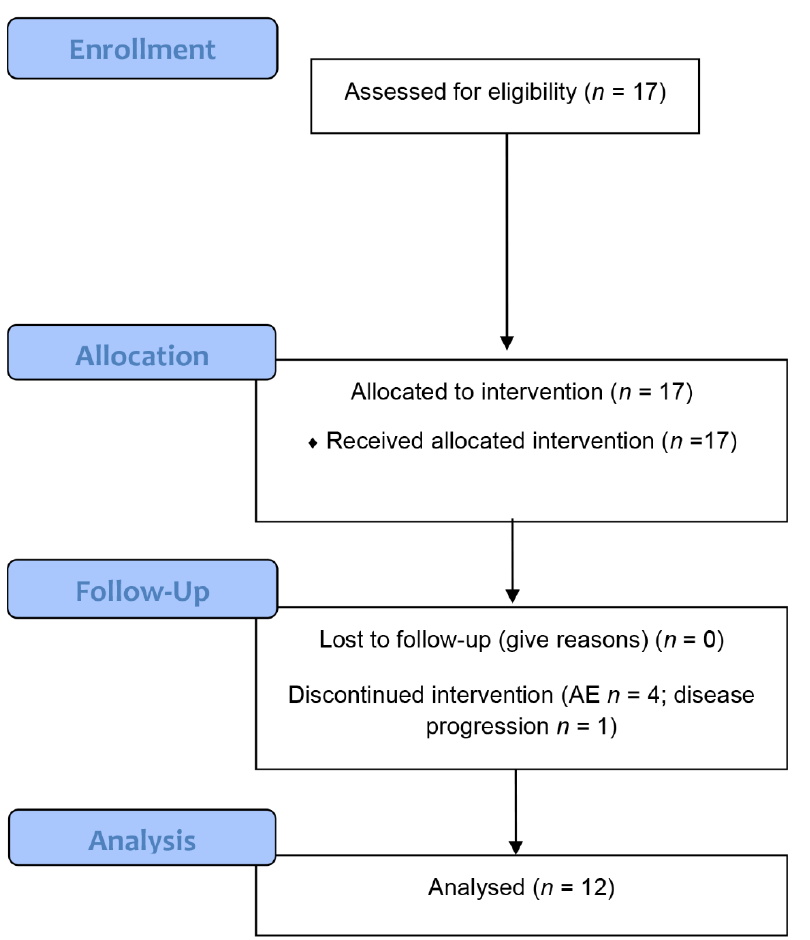
Figure 1. Flow chart of participant disposition. AE = adverse events .